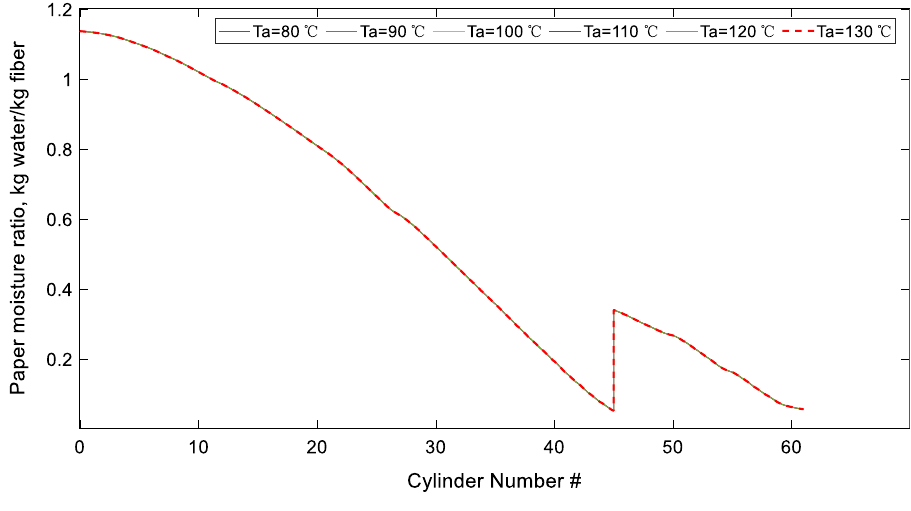
Fig. 7 Effect of supply air tem- perature on the paper moisture